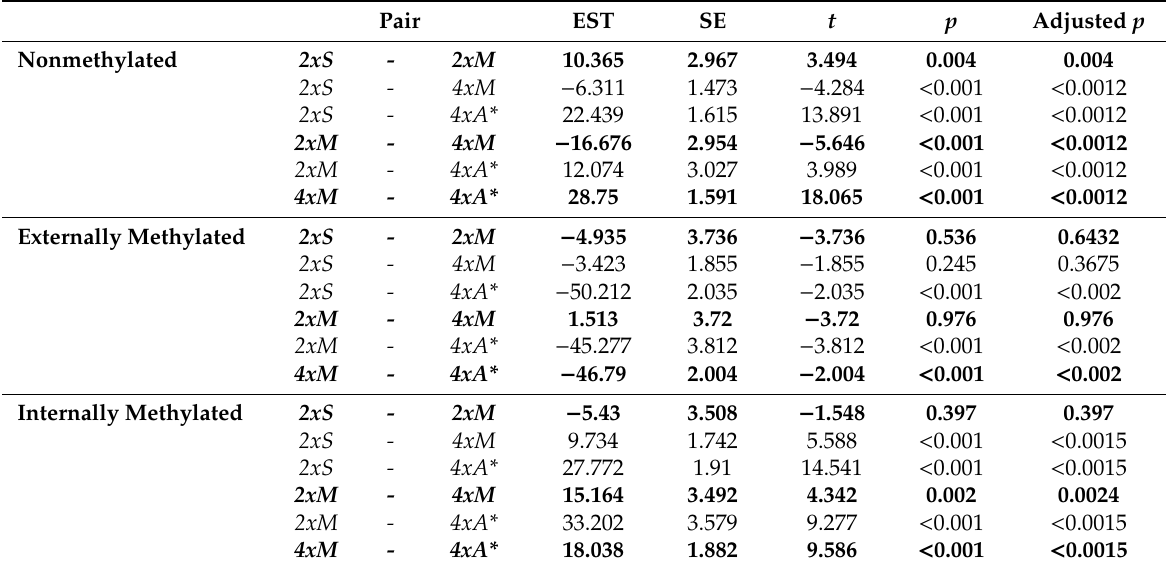
Table 3. Pairwise comparisons of combined groups with ANOVA (analysis of variance) for the di ff erent types of epiloci in R. kuepferi . Pair EST SE t p Adjusted p Nonmethylated 2xS - 2xM 10.365 - < 0.0012